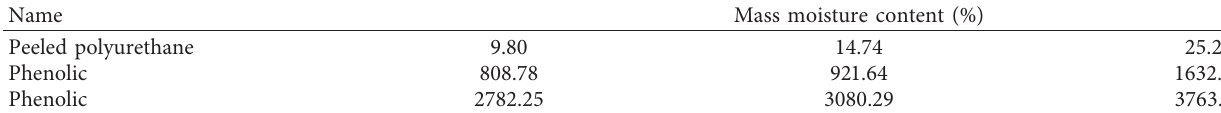
Table 5: Mass moisture contents of the insulation layer